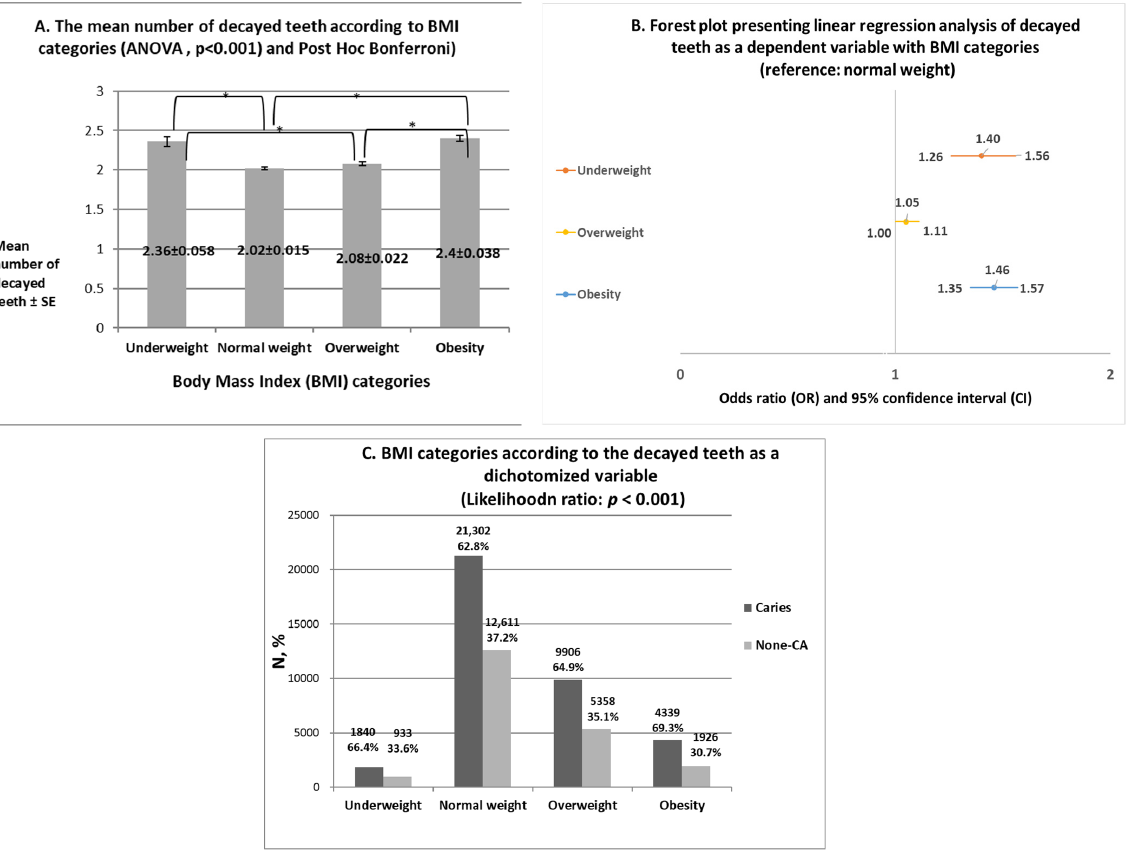
Figure 1. ( A ). ANOVA analysis of the mean number of decayed teeth according to BMI catego- ries:The mean number of decayed teeth according to the four BMI categories: p < 0.001, followed by Post hoc Bonferroni tests: Underweight vs. normal weight ( p < 0.001) and overweight ( p < 0.001), Normal weight vs. obesity ( p < 0.001) Overweight vs. obesity ( p < 0.001). *Statistically significant values in the Post hoc Bonferroni tests. There were no statistically significant differences between normal weight and overweight. ( B ). Forest plot presenting linear regression analysis of the mean number of decayed teeth as a dependent variable with BMI categories (reference: normal weight).